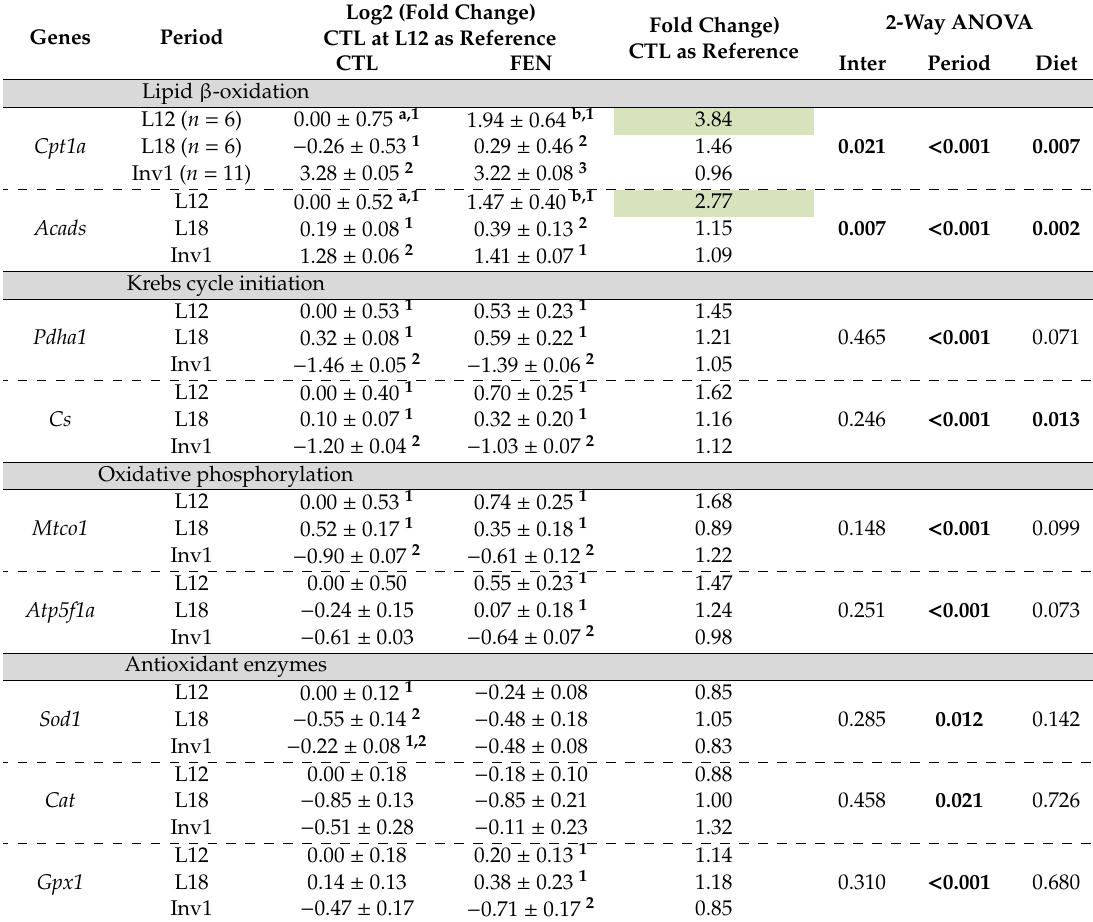
Table 3. E ff ect of fenugreek supplementation on relative expression of genes involved in energy metabolism and antioxidant activity in mammary gland along lactation period.